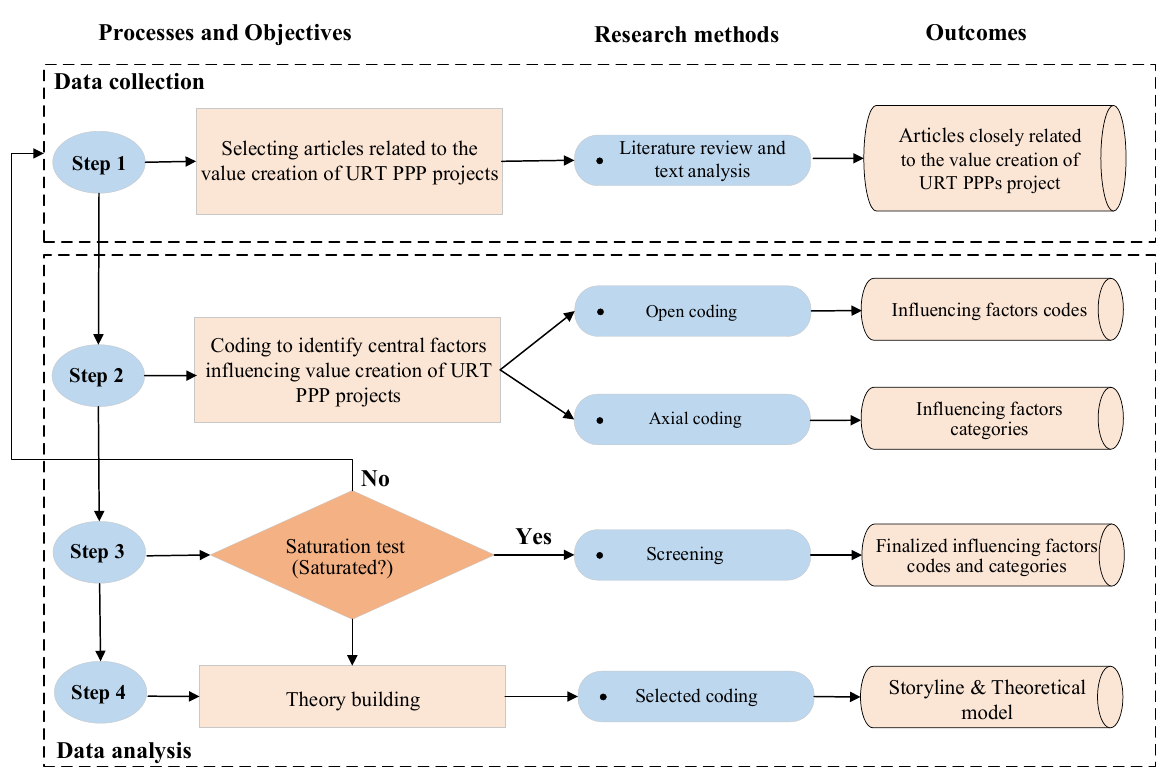
Figure 1. Research process based on grounded theory methodology.